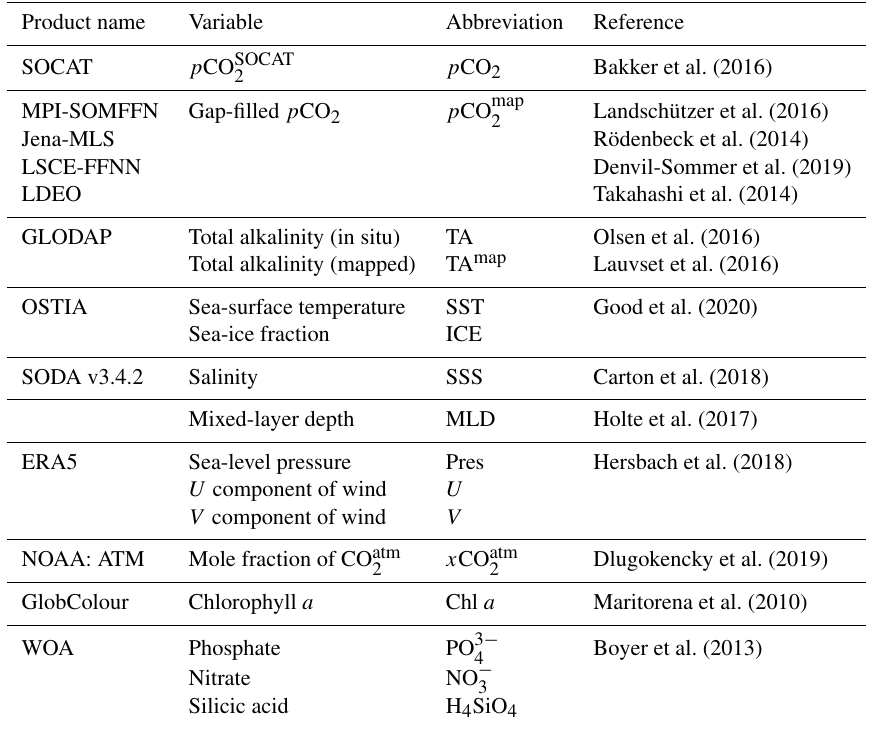
Table 2. Data sources used in this